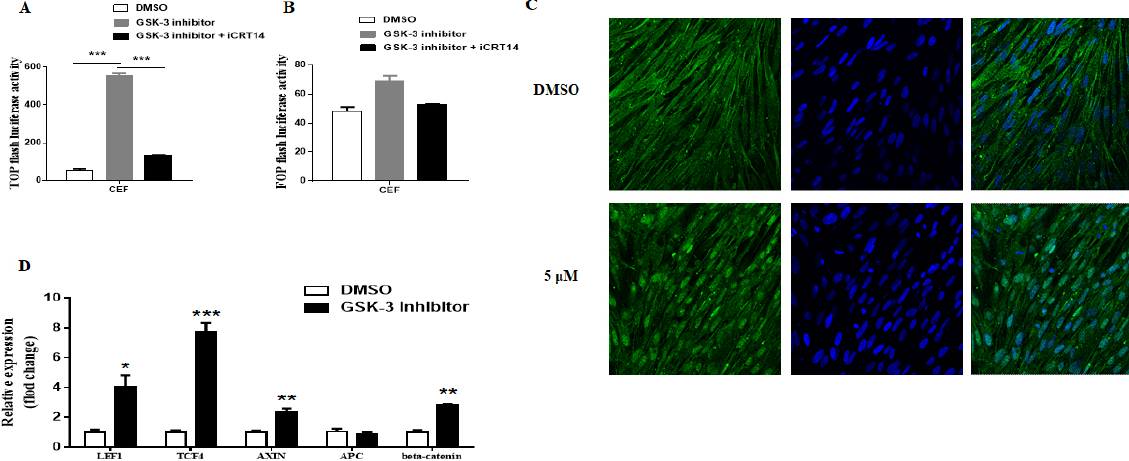
Figure 1. GSK-3 inhibitor activated the Wnt/ β -catenin signaling pathway in CEF cells. Relative luciferase activity of pTOP ( A ) and pFOP ( B ) in CEF cells. GSK-3 inhibitor enhanced the β -catenin/Tcf-dependent transcriptional activity in CEF cells. ( C ) After treatment with GSK-3 inhibitor for 24 h, the cells were fixed and stained for β -catenin (green) and the nuclei (blue). The pictures were captured and merged with a Leica SP2 confocal microscope (magnification, ×630). ( D ) The gene expression levels of Wnt/β-catenin signaling-pathway-associated genes were quantified by real-time RT-PCR. Data were expressed as mean ±SD from three independent experiments and analyzed by Student’s t -tests (* p < 0.05, ** p < 0.01, *** p < 0.001). These experiments were performed independently at least three times with similar results.